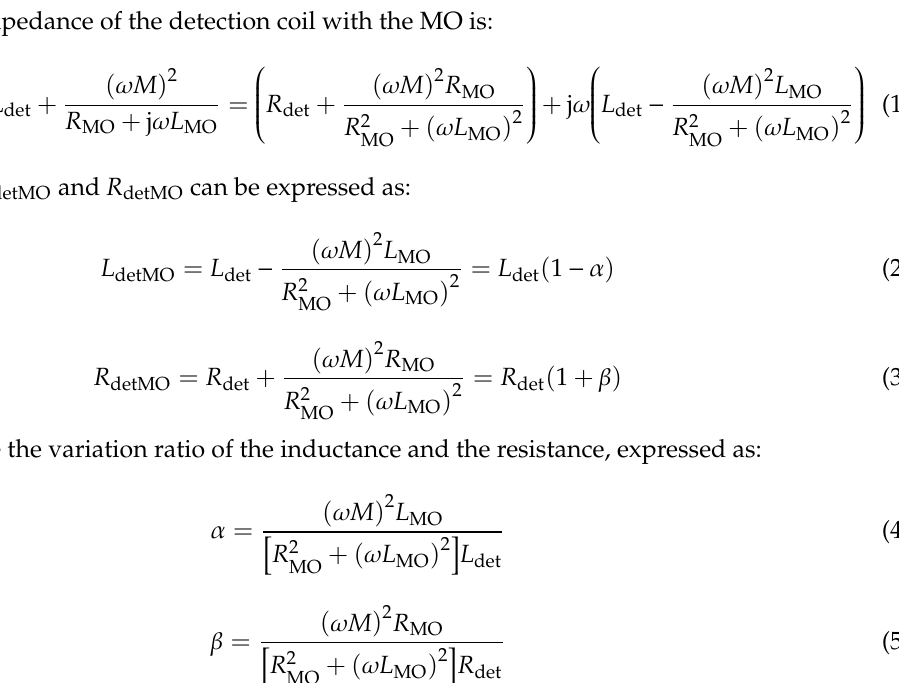
Figure 5. Detection coil with an MO. ( a ) Schematic, ( b ) equivalent circuit.